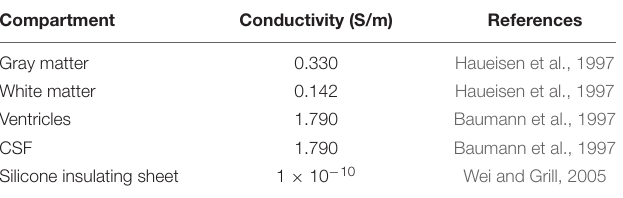
TABLE 2 | Head model conductivities of each